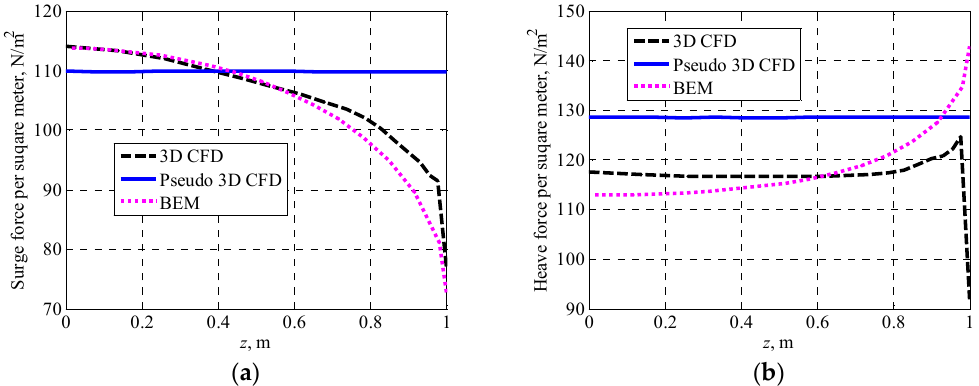
Figure 17. Comparison of hydrodynamic forces per square meter along longitudinal direction of the Duck among 3D CFD, pseudo 3D CFD and BEM results at t = 8.544 s when T = 1.6 s and H = 0.075 m: ( a ) surge force; ( b ) heave force.